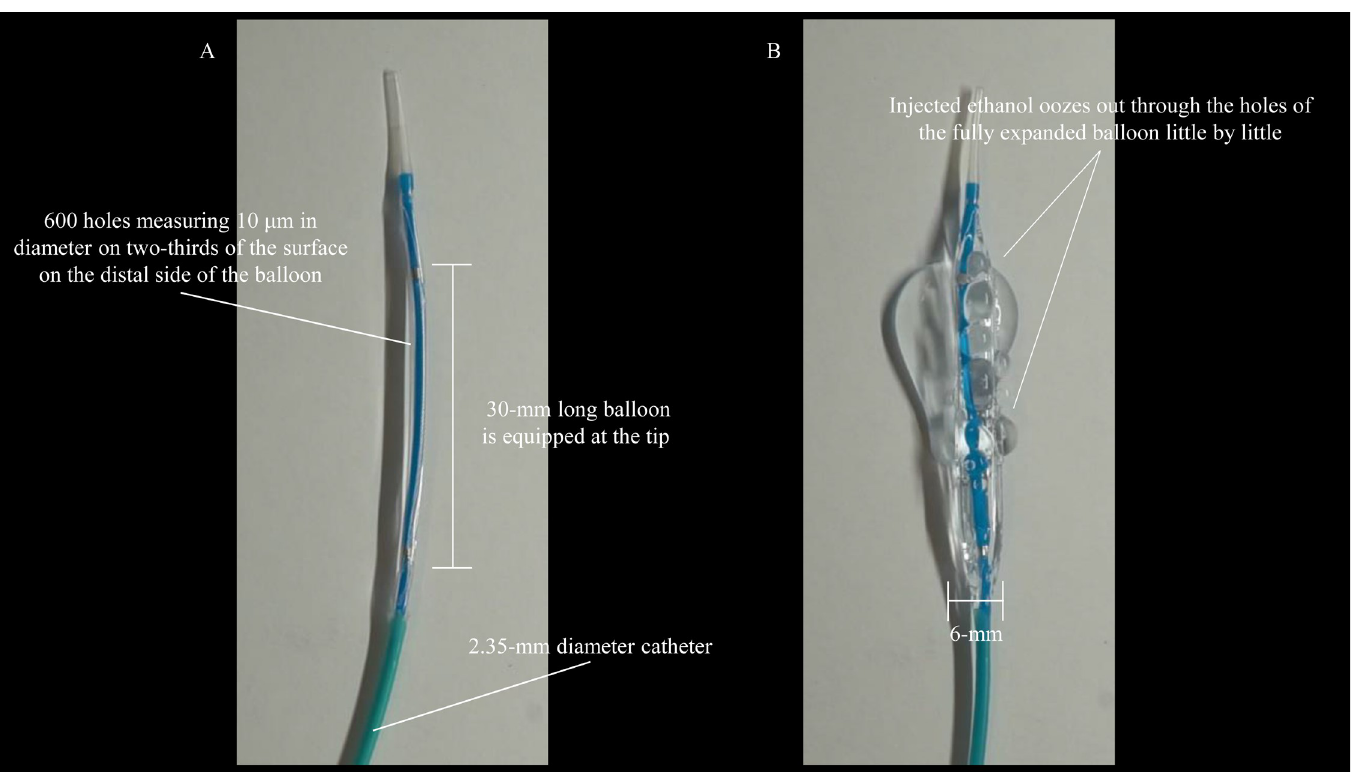
Fig 1. Prototype of the newly developed multi-hole balloon catheter equipped with a 30-mm long balloon of 6, 8, or 10 mm diameter, which has 600 holes of 10 μ m diameter on two-thirds of the surface on the distal side of the balloon ( A ). When ethanol is injected into the balloon, the balloon expands initially until the full size is achieved; subsequently, a small amount of ethanol gradually oozes out of the balloon through the holes ( B ).